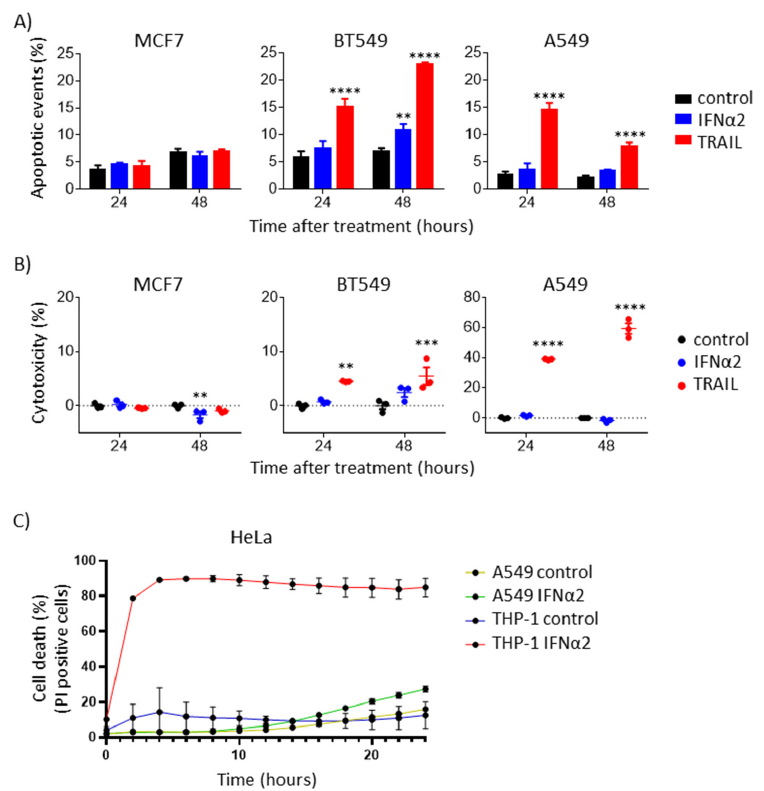
Figure 4. TRAIL upregulation by IFN α in epithelial cancer cells is not enough to induce apoptosis. ( A ) TRAIL upregulation by IFN α did not induce apoptosis in most cancer cells. Breast cancer cells MCF7 and BT549 and lung cancer cells A549 were treated with 0.8 µg/mL IFN α 2 or 0.5 µg/mL TRAIL. After 24 or 48 h, apoptosis was quantified with Annexin V staining using flow cytometry. ANOVA followed by Dunnett’s multiple comparison test was performed (** p < 0.01 and **** p < 0.0001). ( B ) TRAIL upregulation by IFN α did not induce cytotoxicity in cancer cells. Breast cancer cells MCF7 and BT549 and lung cancer cells A549 were treated with 0.8 µg/mL IFN α 2 or 0.5 µg/mL TRAIL. After 24 or 48 h, cytotoxicity was quantified using the lactate dehydrogenase cytotoxicity assay. ANOVA followed by Dunnett’s multiple comparison test was performed (** p < 0.01, *** p < 0.001 and **** p < 0.0001). ( C ) TRAIL upregulation by IFN α in epithelial cancer cells did not induce cell death in a paracrine manner. THP-1 and A549 were treated with 0.8 µg/mL IFN α 2 or control. After 48 h, the supernatants were collected, centrifuged and supplemented with 1 µM BV6 and 1 µg/mL PI. Cell death induction by the conditioned media was monitored in real time for 24 h using HeLa as target cells. Cell death is represented as the percentage of PI-positive cells.